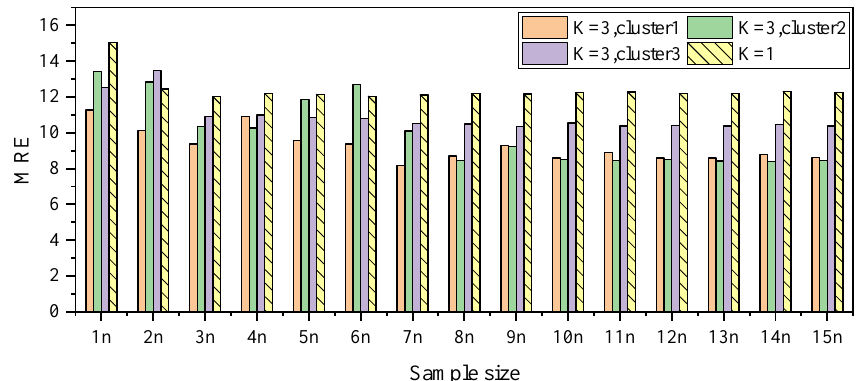
Figure 5. MRE comparison in different cluster ( K =